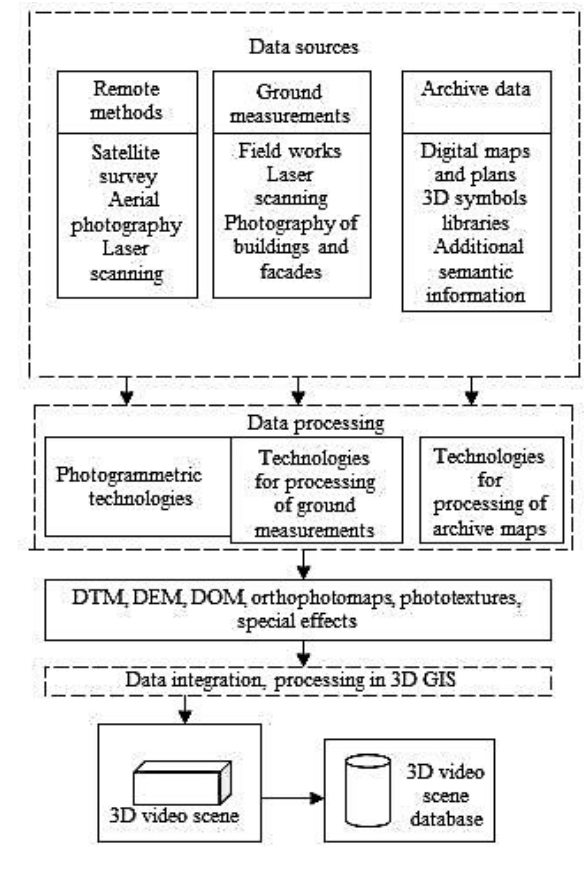
Figure 2. A generalized flow